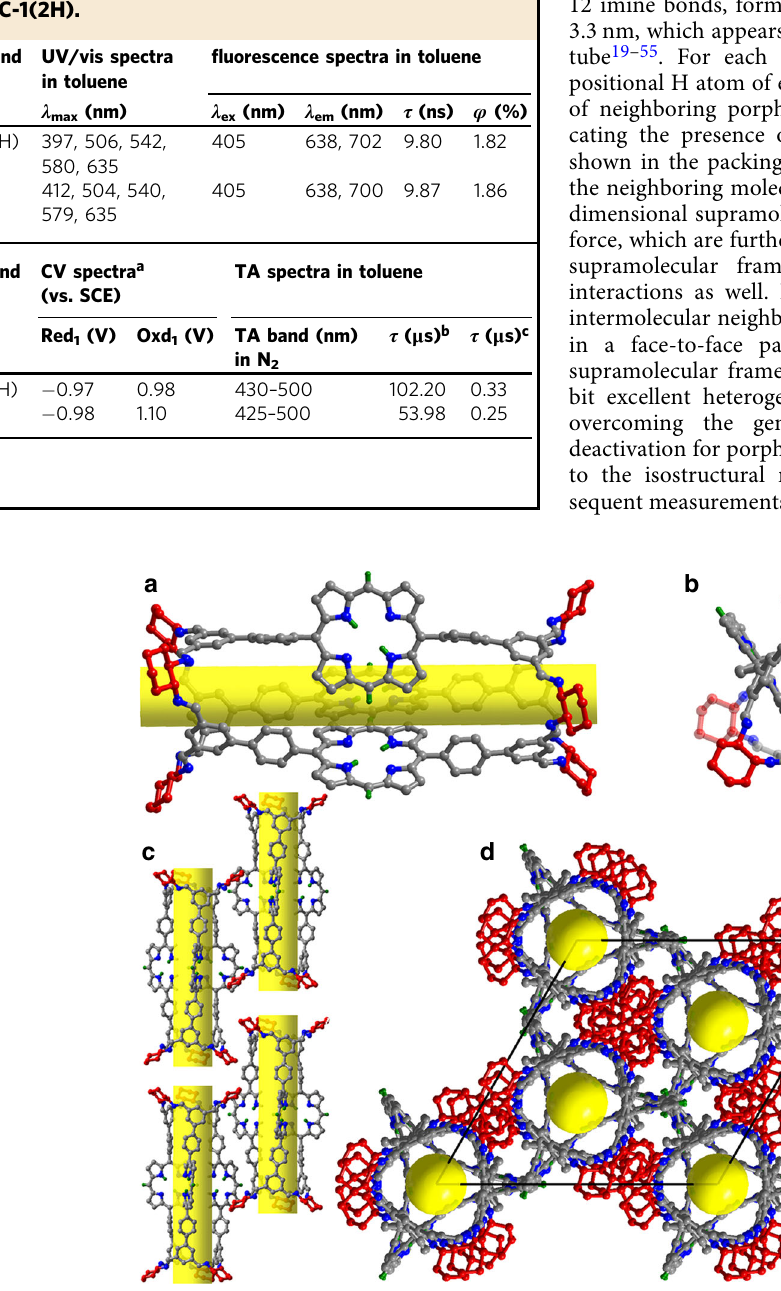
Fig. 2 Single crystal structure of molecular organic cage (R)-PTC-1(2H). a Side view and b top view; c window-to-window stacking mode of neighboring molecular organic cages; d packing pro fi le along the direction of [001] (porphyrin C, gray; cyclohexanediamine C, red; N, blue; H, green; yellow tubes and balls represent the open one-dimensional channel and window, respectively; all selected hydrogen atoms omitted for